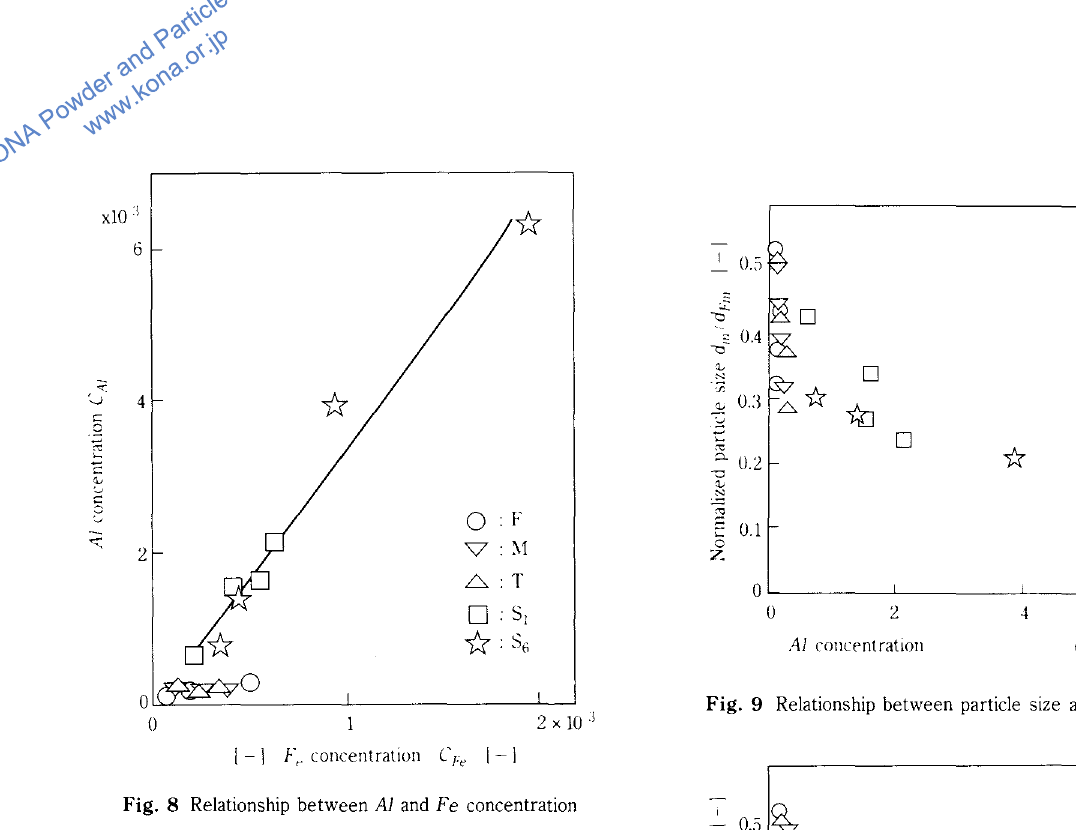
Fig. 8 Relationship between Al and Fe concentration when using 51 or 56 ridged discs, while only Fe concentration increases in the case of discs F, MorT.